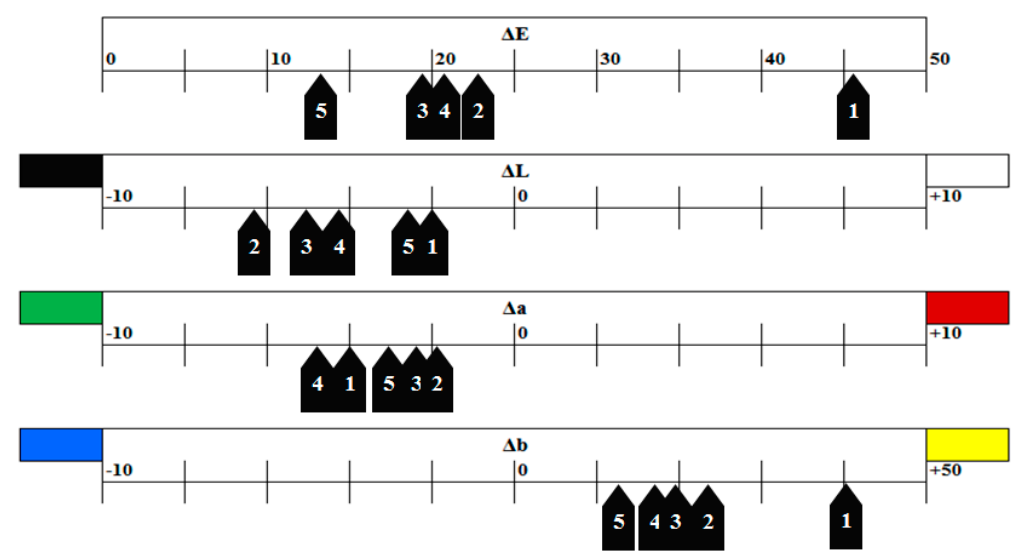
Figure 4. Changes in the CIE Lab parameters for the 5 tested materials after 90 days of immersion in tea solution. (1) Filtek Z350, (2) Filtek Bulk-Fill, (3) Tetric N-Ceram Bulk-Fill, (4) Sonic Fill 2, and (5) SDR. Δ E: overall shade change, Δ L: changes in lightness and darkness, Δ a: changes in the red-green axis, Δ b: changes in the blue-yellow axis. Please note different scales used for each parameter.